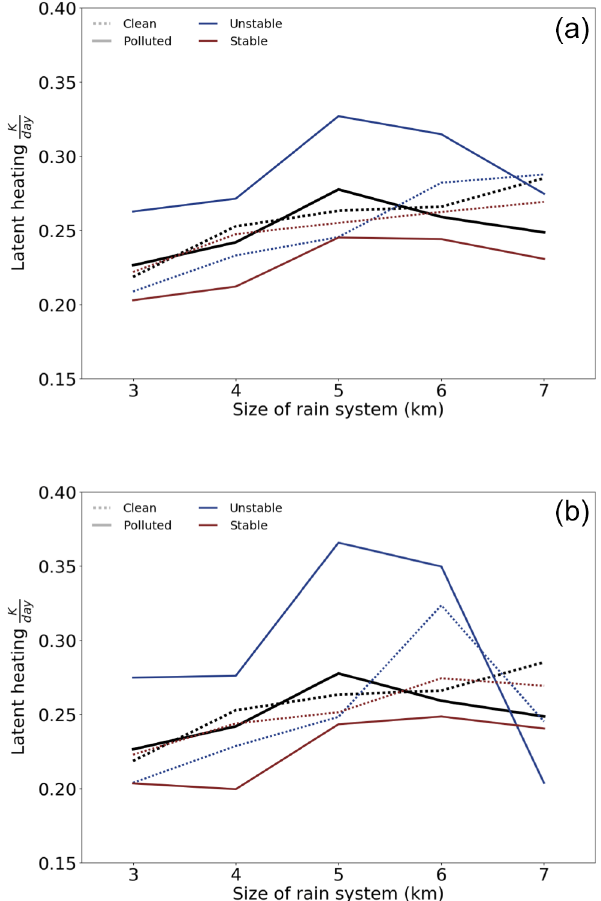
Figure 3. The maximum rate latent heat release due to precipita- tion within the cloud as a function of rain system size for all (a) and dry (b) warm clouds with an extent of 15km. Black is for all stabilities, blue is for unstable environments, and red is for stable environments; dashed represents pristine and solid represents pol- luted